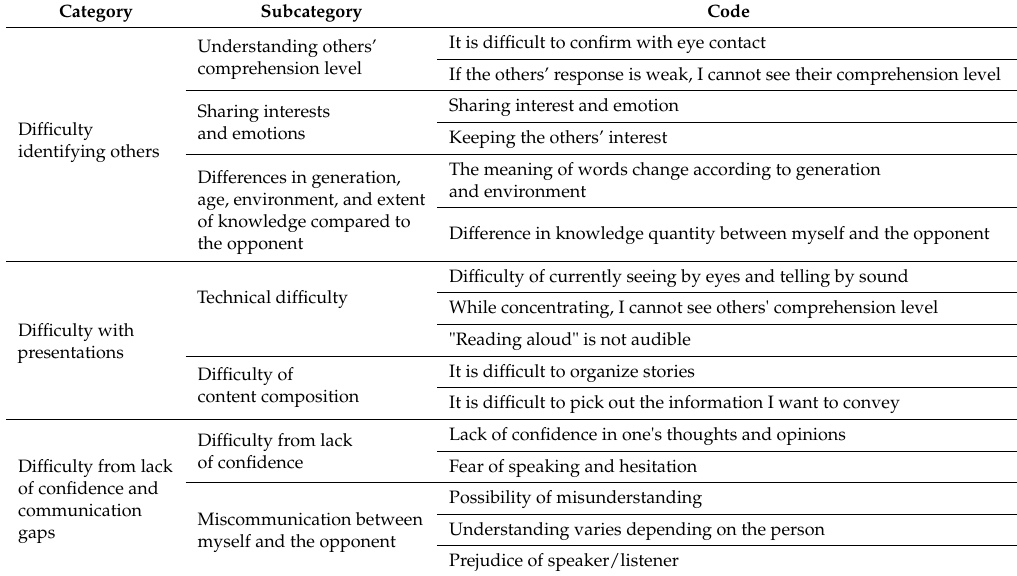
Table 3. Content categorization of Task 2 responses to “What is difficult when you tell others about an